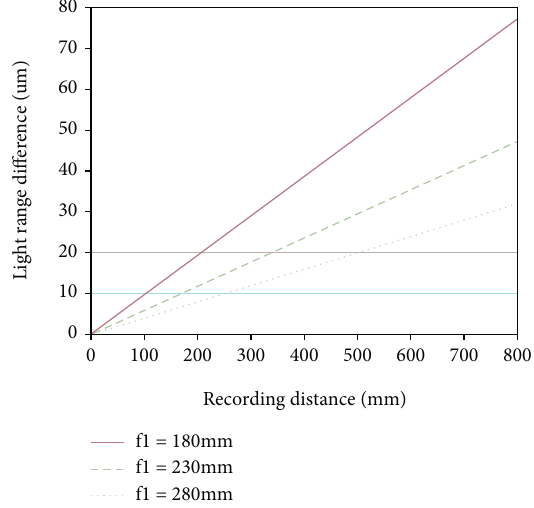
Figure 12: Variation curve of optical range di ff erence δ after increasing coherence 13 length (plane recording distance z h wave plus spherical